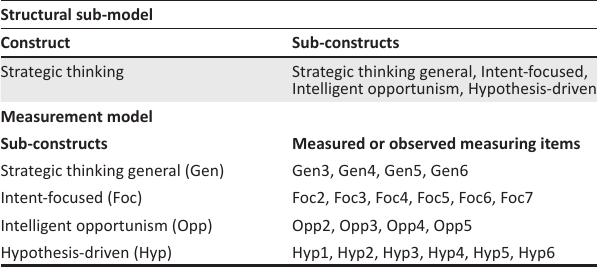
TABLE 6: Definition of structural and measurement model for strategic thinking and its sub-constructs.